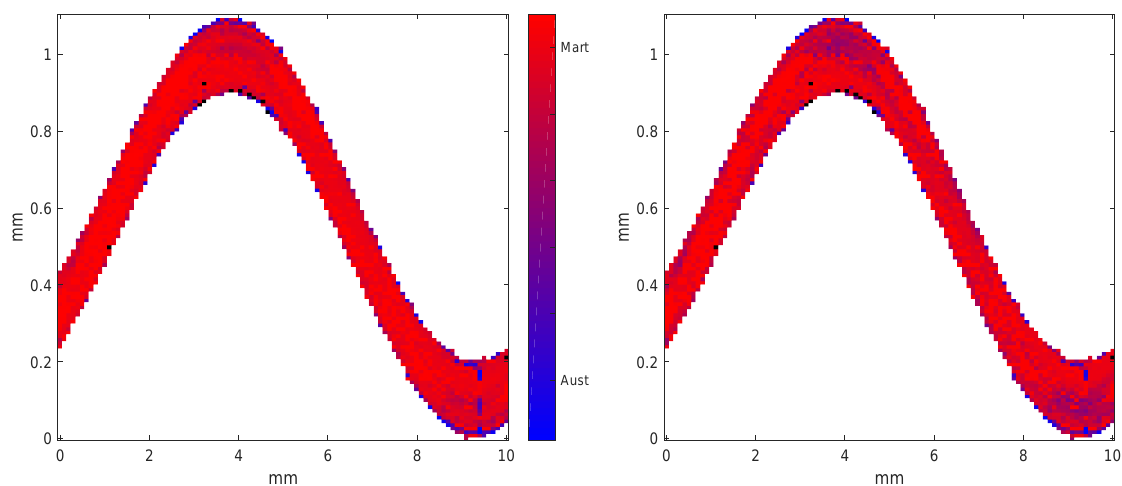
Figure 3. Relative volume fractions of austenite and martensite with respect to the whole diffracting volume. In the left-hand figure the fibre-texture correction was applied, while on the right it was the no-texture approximation. The martensite is being represented by red channel, the austenite by the blue one.